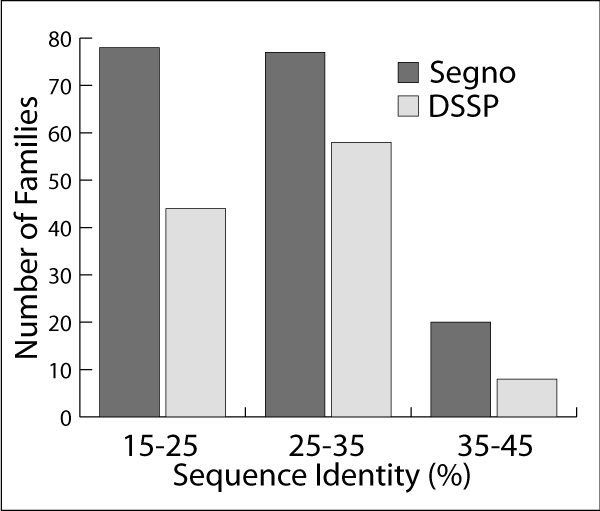
Secondary-structure guided sequence alignments for SEGNO and DSSP over a range of sequence similarities. Bars indicate proportion of cases where SEGNO gives a more accurate alignment than DSSP (dark bars) or where DSSP gives a more accurate alignment than SEGNO (light bars). Total number of observations in each bin are: 15–25%, 122; 25–35%, 135; 35–45%, 28.